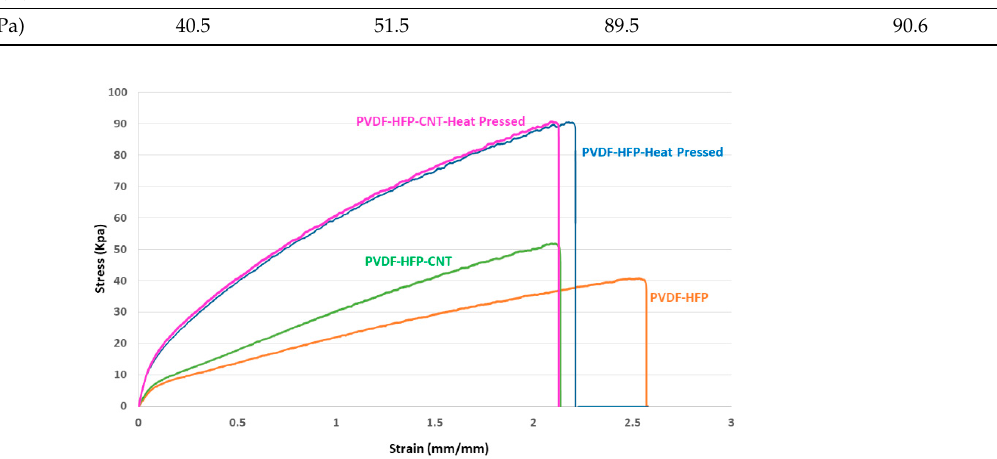
Figure 4. Mechanical characteristics of the electrospun PVDF-FHP and CNT-modified PVDF-HFP membranes before and after heat pressing.